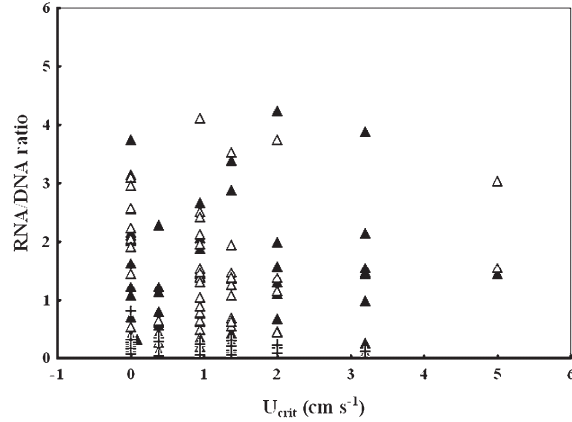
Fig . 4. – Relationship between RNA/DNA ratio and U of fed and crit starved larvae of S. senegalensis . Closed triangles represent fed fish, open triangles represent short starvation fish, and cross symbols rep- resent long starvation fish. The x-axis is scaled to start at -1 instead of 0 for a better visualization of the